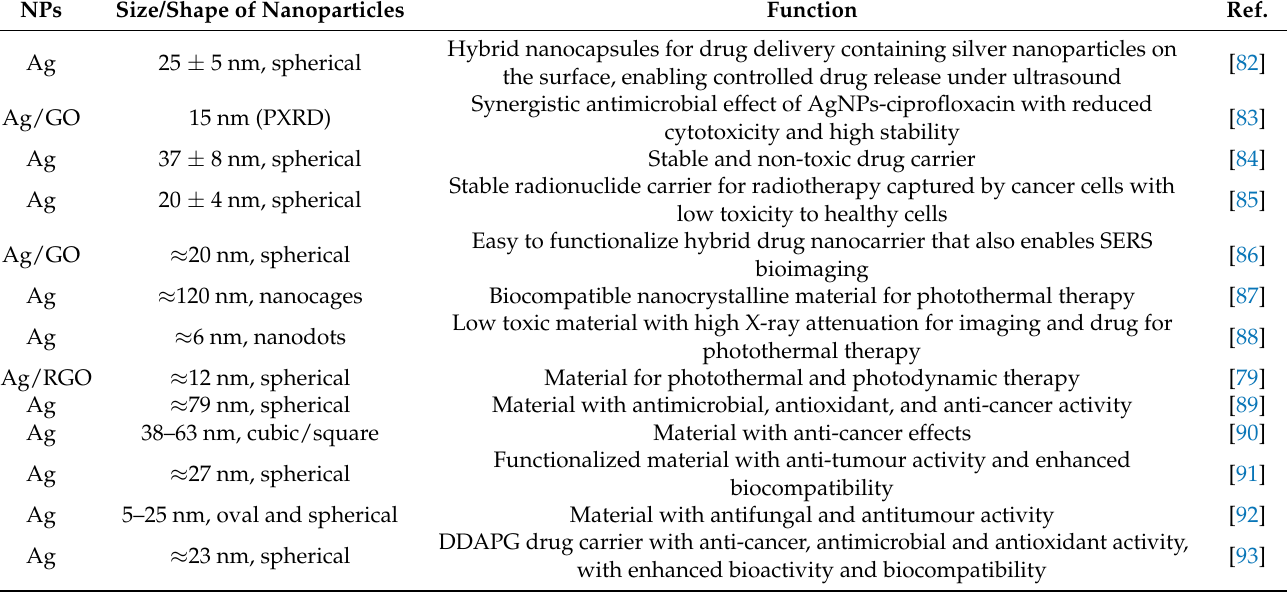
Table 1. The morphology of the nanoparticles, the presence of additives that functionalize their surface, as well as the functions they performed in the described studies, are compared. Table 1. Metal and non-metal nanoparticles used in anti-cancer